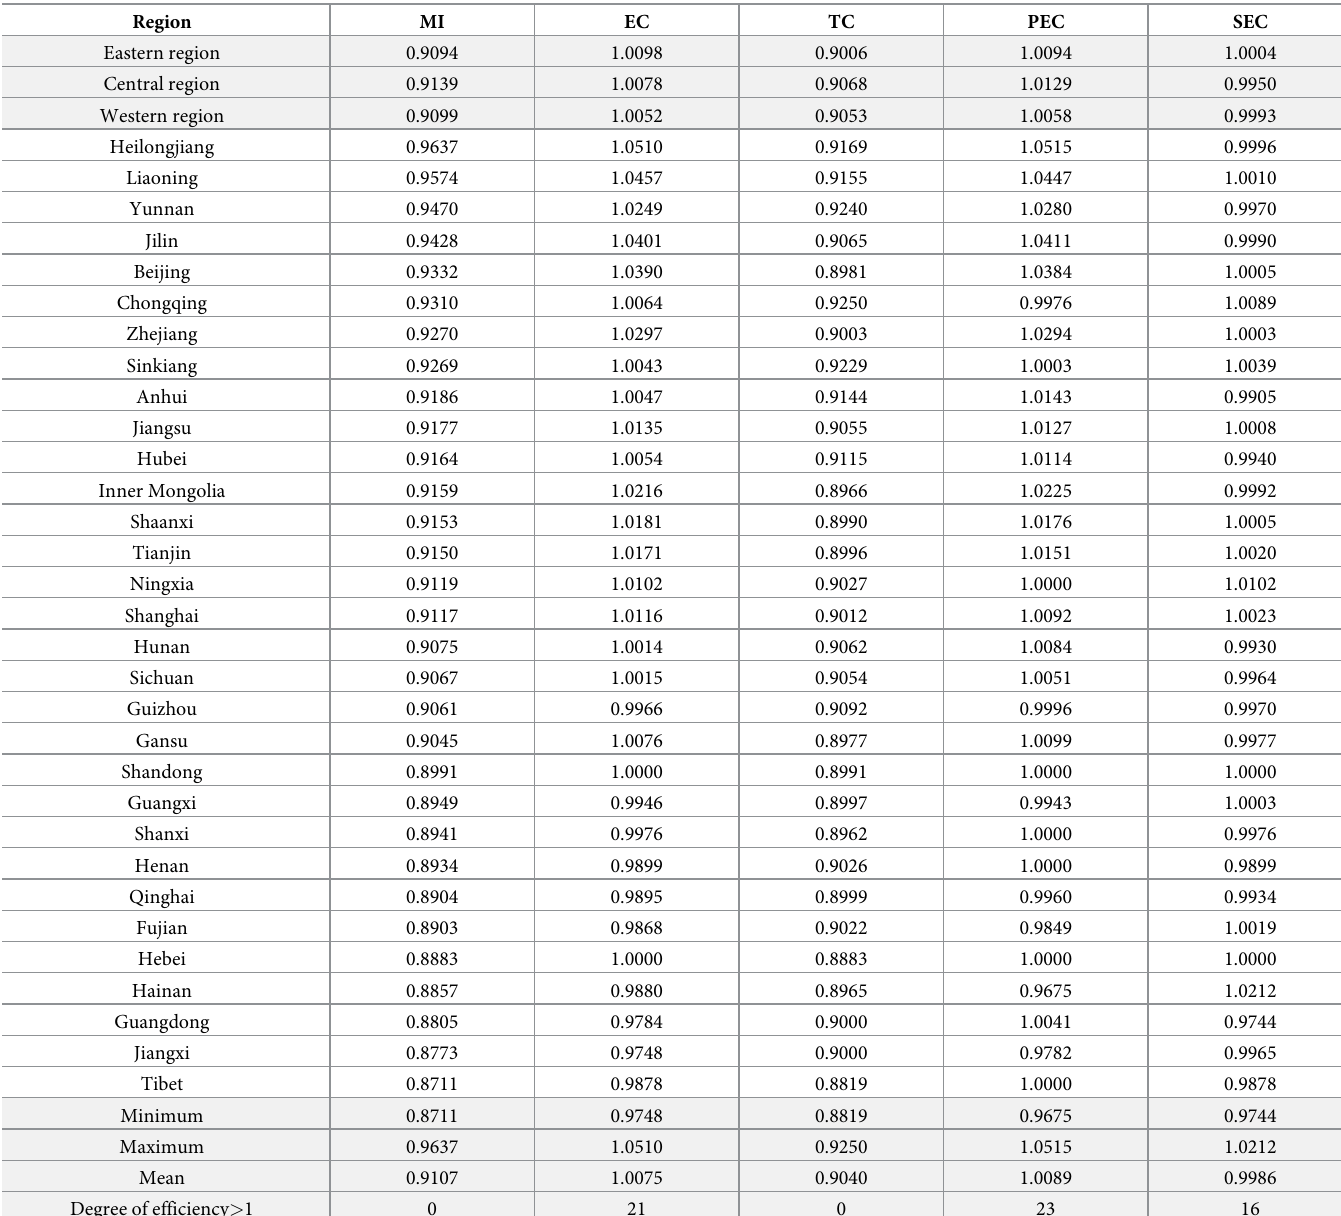
Table 3. TFP of the 31 provinces in China after the NHCR